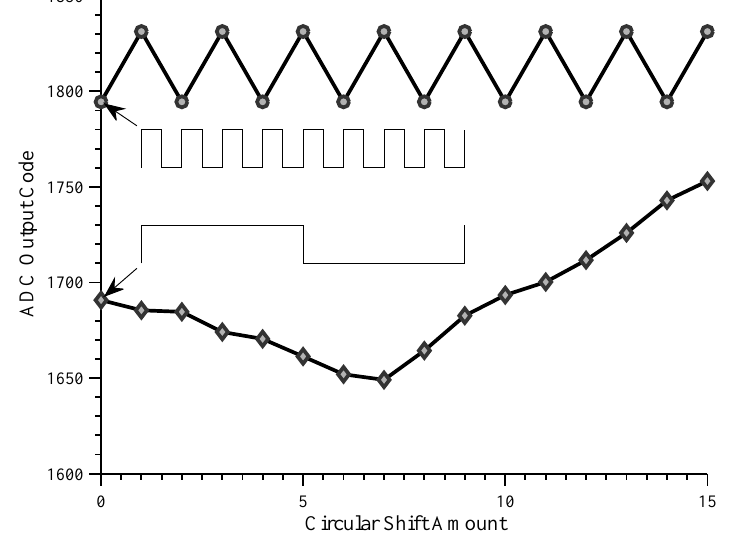
Figure 11. Channel 4L output for two circularly shifted chipping